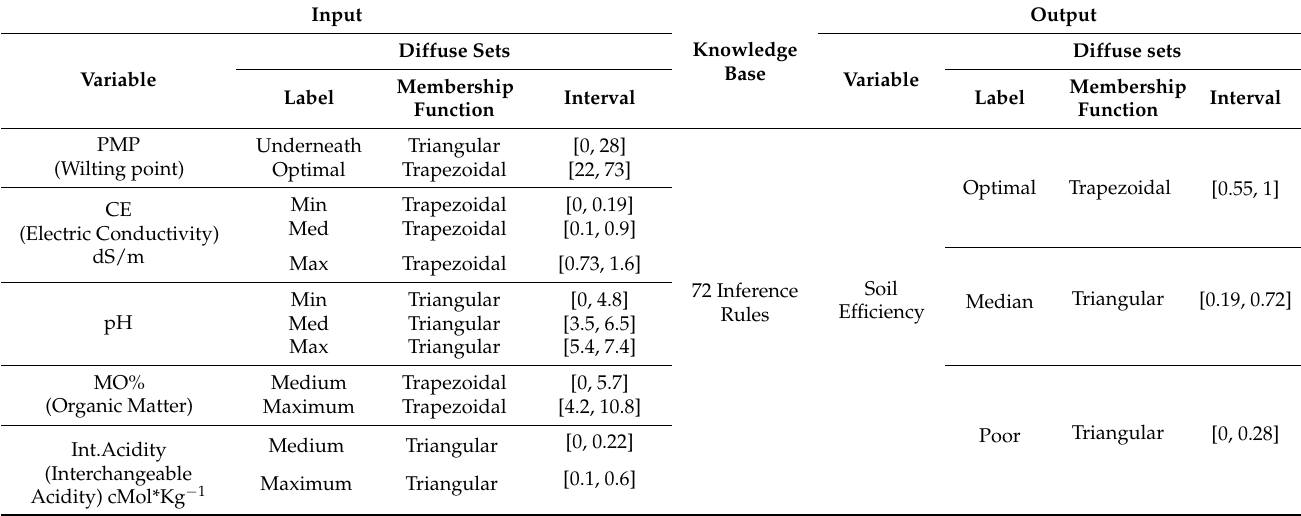
Table A4. Non-nutritional disorders model: fuzzy sets and operation